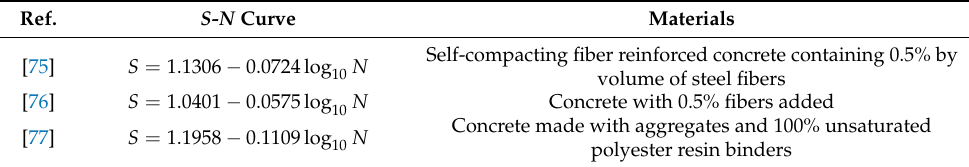
Figure 13. S-N curve for different samples. Table 5. S-N curves reported in the